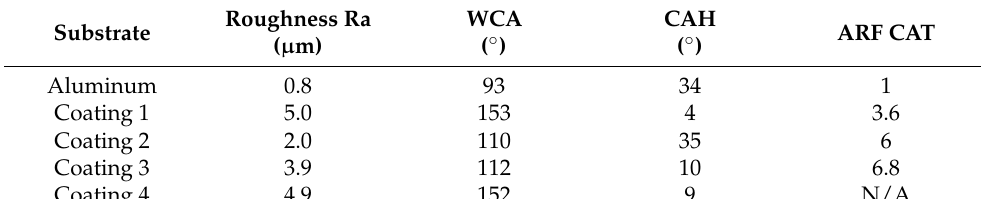
Table 2. Substrate characteristics.